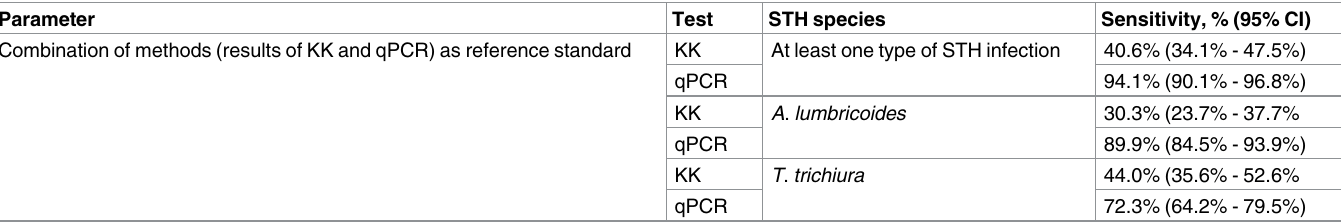
Table 5. Diagnostic accuracyof triplicate thick smear KK and qPCR using the combined results of the KK and qPCR as referencestandard in stool samples from 263 schoolchildren in Laguna province, Philippines. Parameter Test STH species Combination of methods (results of KK and qPCR) as reference standard